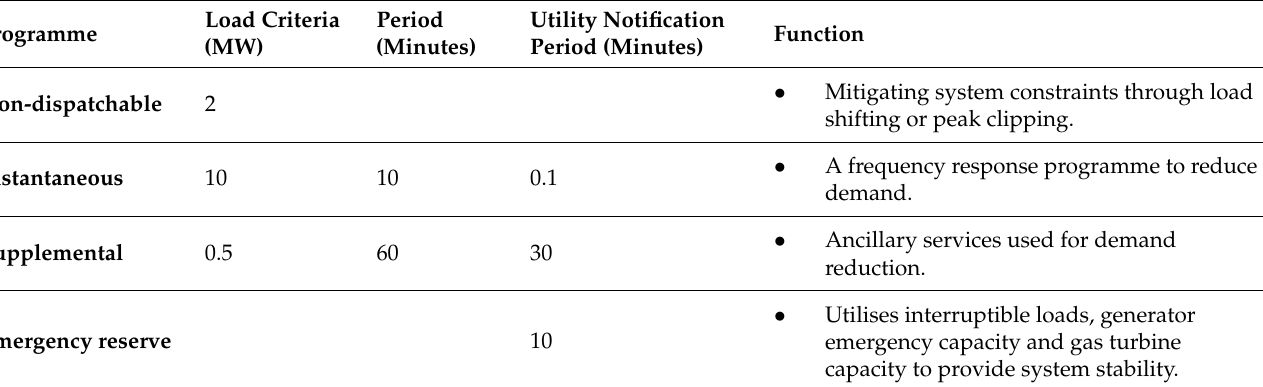
Table 7. DR programmes in South Africa [97,98].